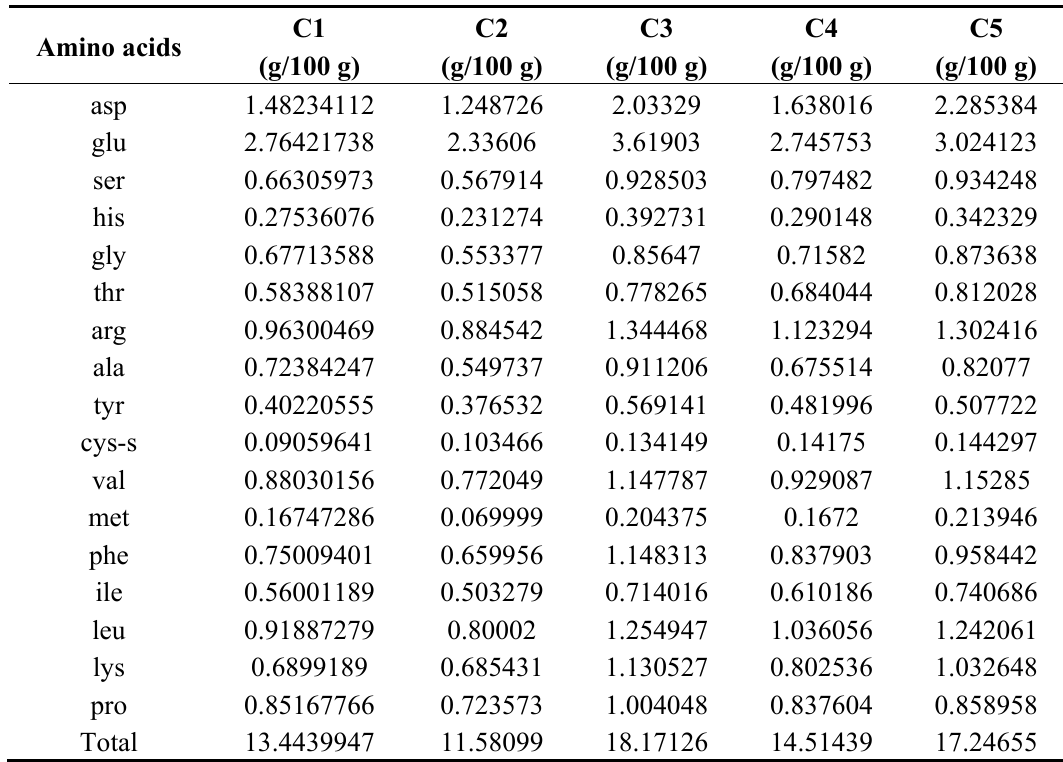
Table 3. The concentration of total amino acids (g/100